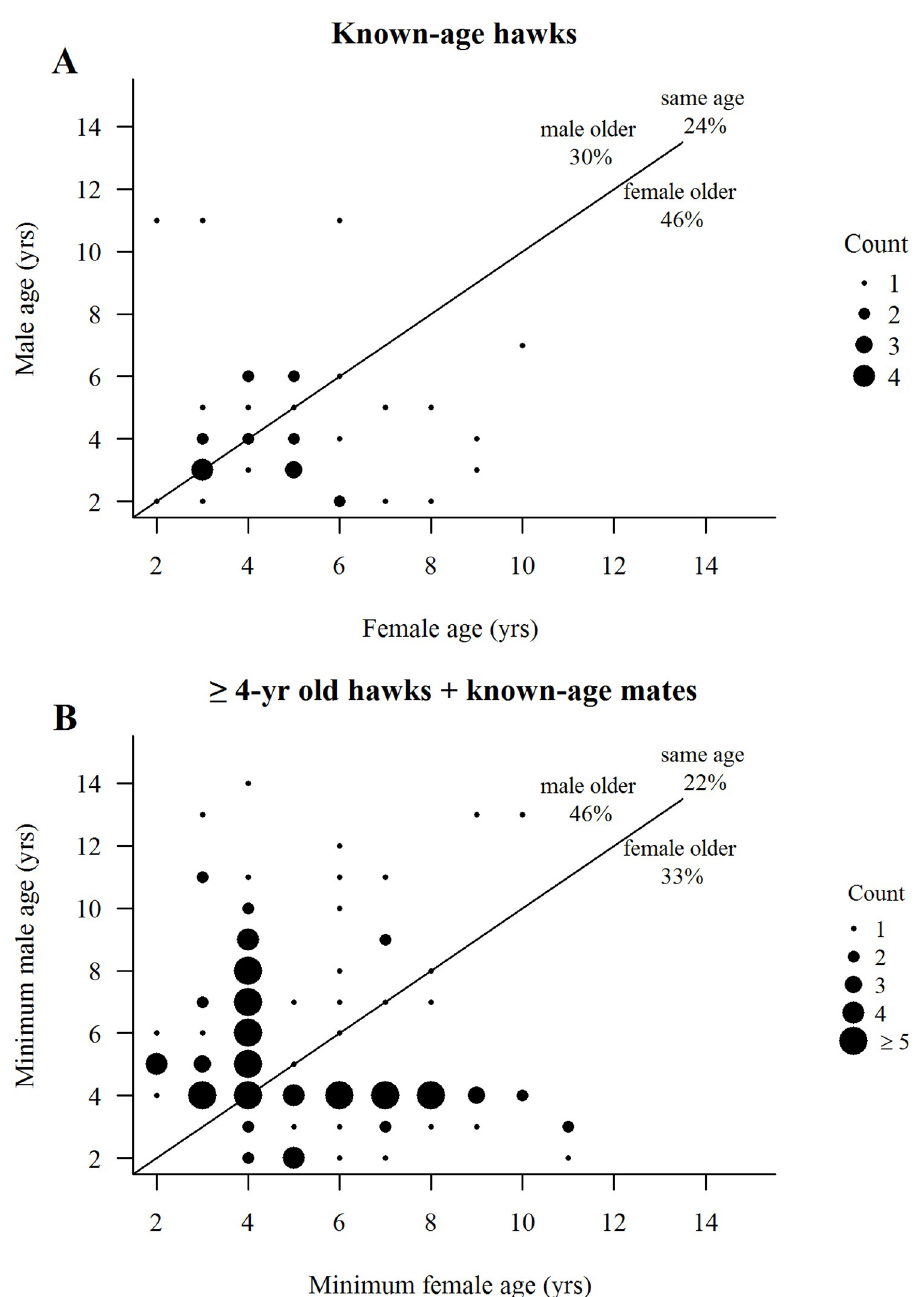
Fig 8. Is mate choice based on mate age? (A) Mate age composition of 37 pairings (33 males, 32 females) of known- age hawks, and (B) mate age composition of 169 pairings (120 males, 139 females) of hawks aged � 4-year-old (including their known-age mates where relevant) in the year of pair formation by northern goshawks on the Kaibab Plateau, Arizona, USA. Size of dots indicates numbers of pairs observed in each mate-age category. Solid lines depict one-to-one